Question: Name the type of graph shown.
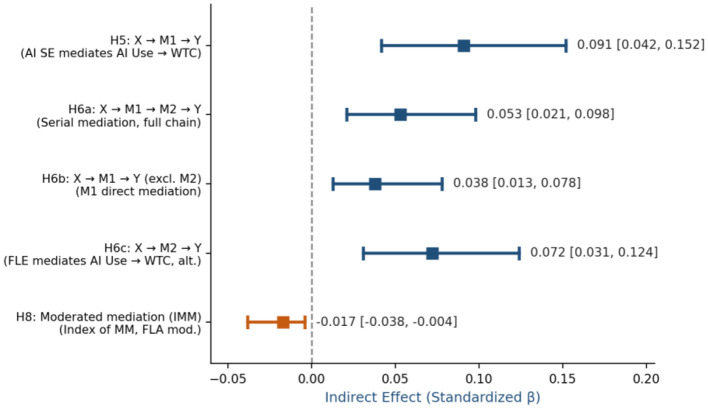
Answer: forest